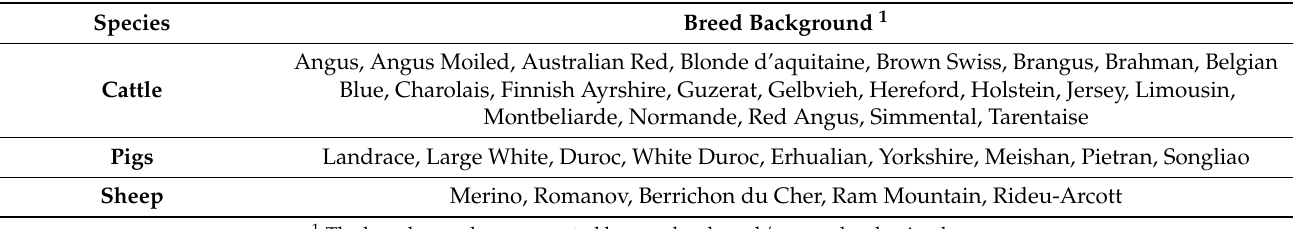
Table 1. Breeds represented in the systematic review for the three species.